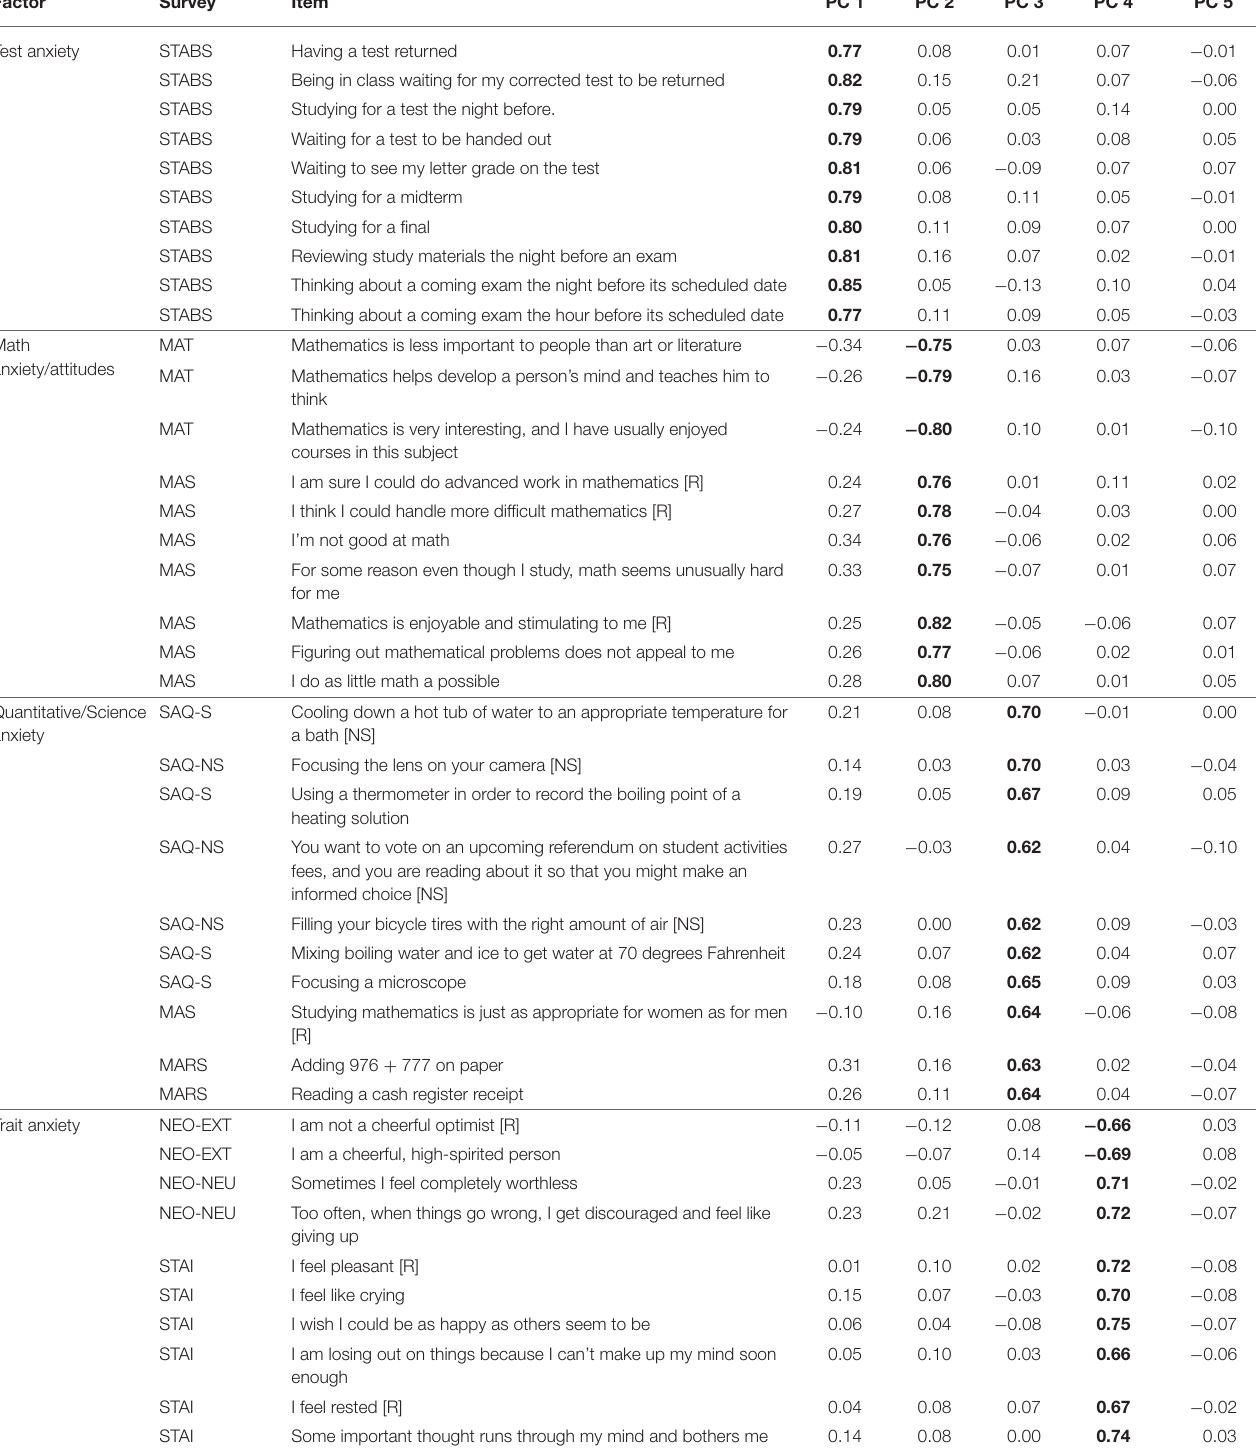
TABLE 3 | Items identified by item-wise PCA in Study 1 for each of 5 principal components: test, math, science/quantitative, trait, and writing. Factor Survey Test